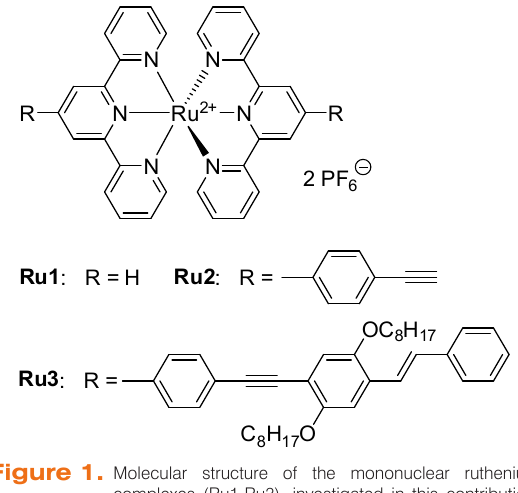
Figure 1. Molecular structure of the mononuclear ruthenium complexes (Ru1-Ru3), investi gated in this contribution. Ru2 bears an ethynyl function rendering it a suitable reactant for click